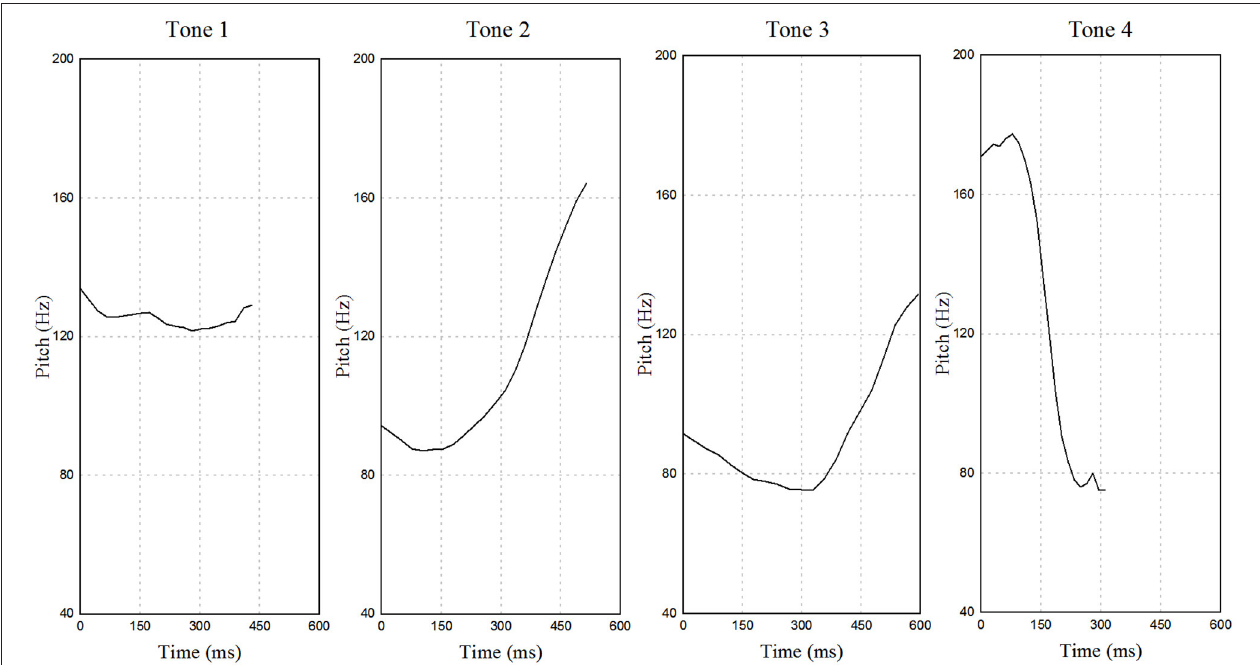
FIGURE 1 | Time by frequency representations of four Mandarin lexical tones borne on monosyllable /pa/ uttered by a male native